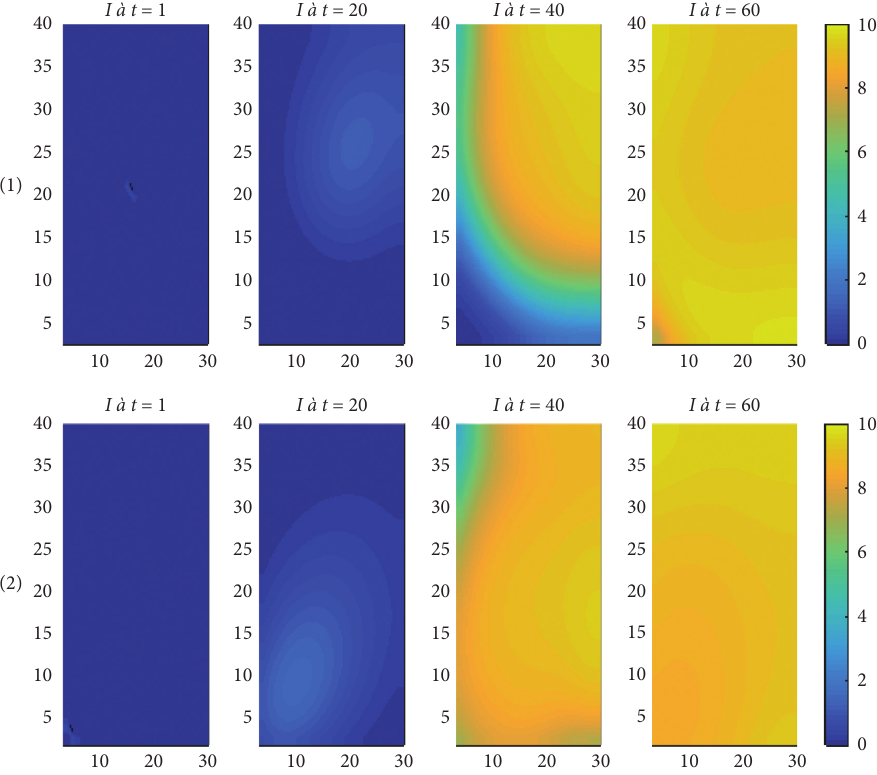
Figure 3: Infected behavior within Ω without control.